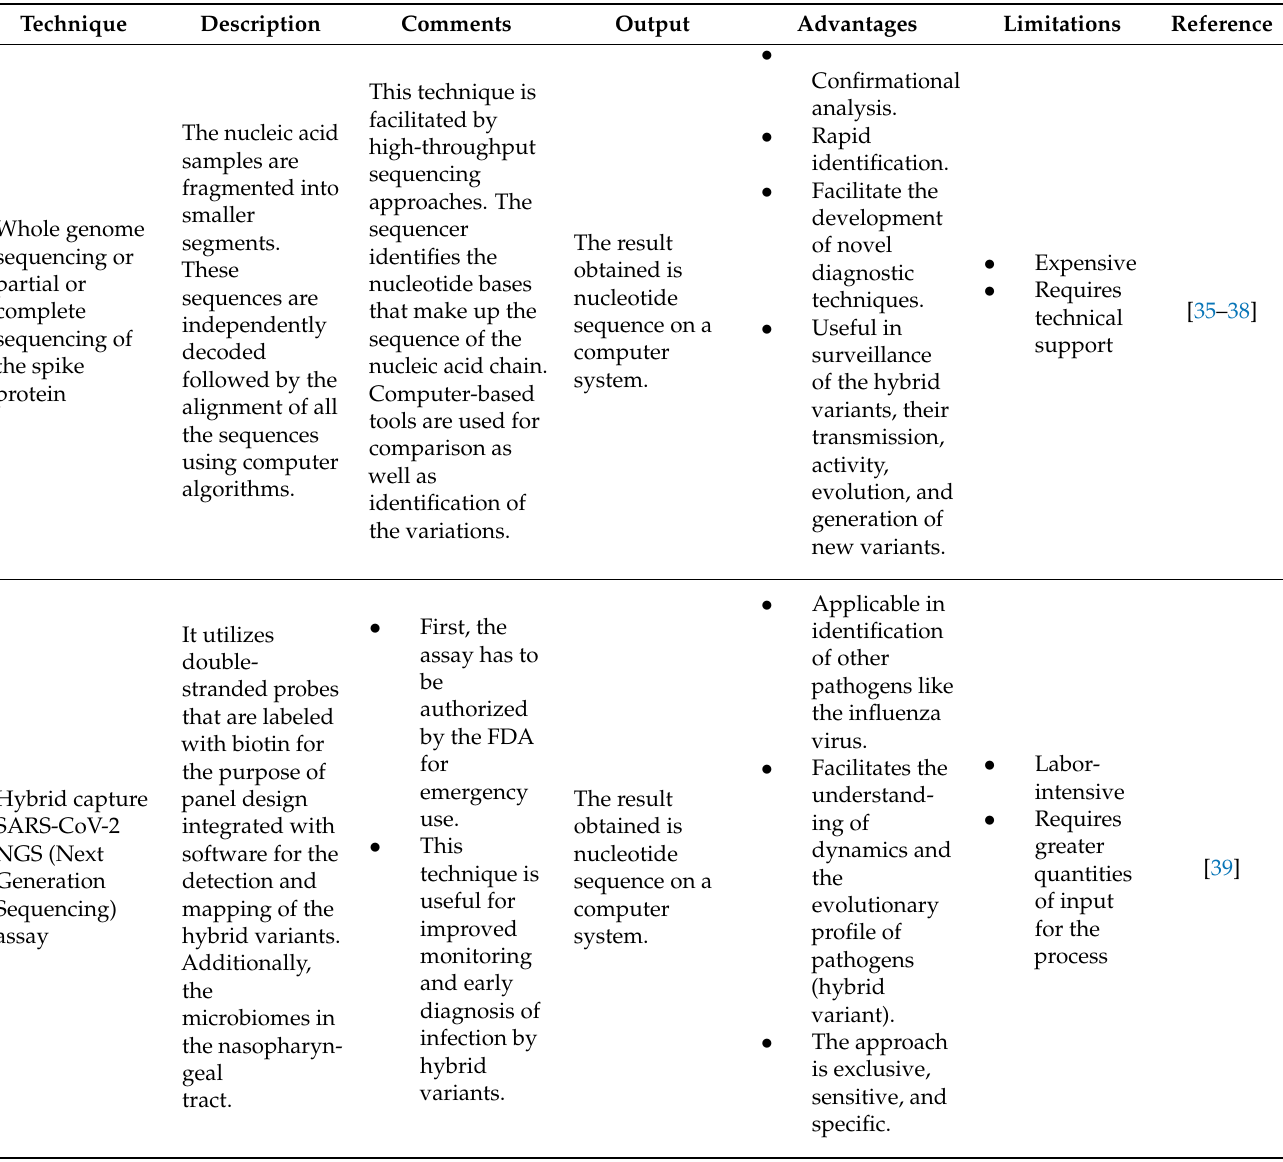
Table 2. Techniques for the identification of hybrid